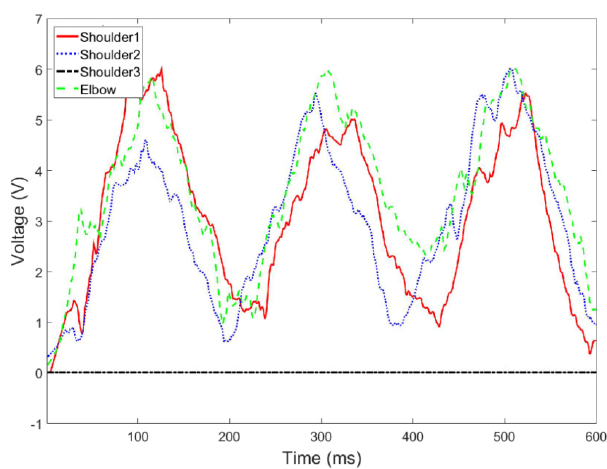
Figure 15. Control signals for the FSMC.